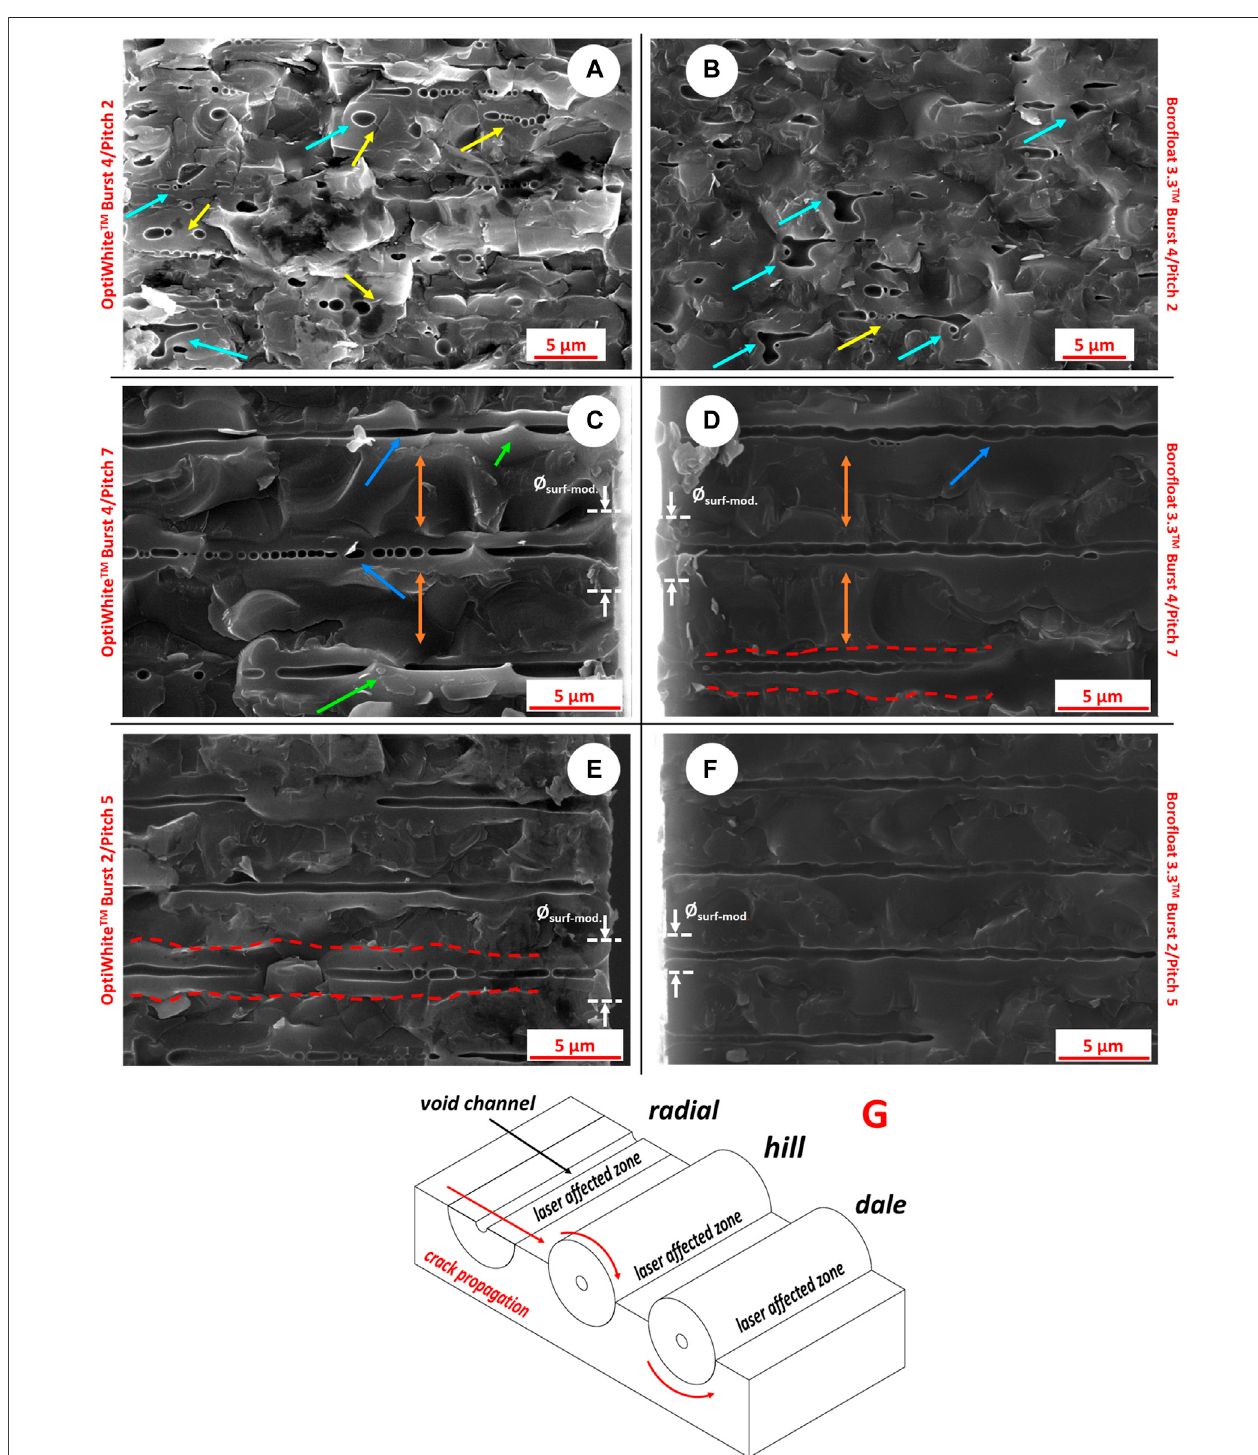
FIGURE 9 | Exemplary SEM images of the cut edge to highlight special features of void formation and void channels (OptiWhite TM : left column (A, C, E) /Boro fl oat 3.3TM: right column (B, D, F) ). In (A,B) samples prepared with Burst 4/Pitch 2 show strong interaction of adjacent fi laments with merging of void channels, large-, singular-,andagglomerationofvoids(turquoisearrows).In (A) microcracksstartingfromthevoidscanbevisuallyidenti fi ed(yellowarrows).SamplespreparedwithPitch 7 (C,D) presentwell-separatedvoidchannels(orangedoublearrow)andgeneraldifferencesofthevoidchannelscanbeseen(bluearrows).OptiWhite ™ (C) shows a mix of longer and singular voids due to pinching caused by nonlinear propagation of the laser, whereas Boro fl oat 3.3 ™ (D) shows long and open channels that are